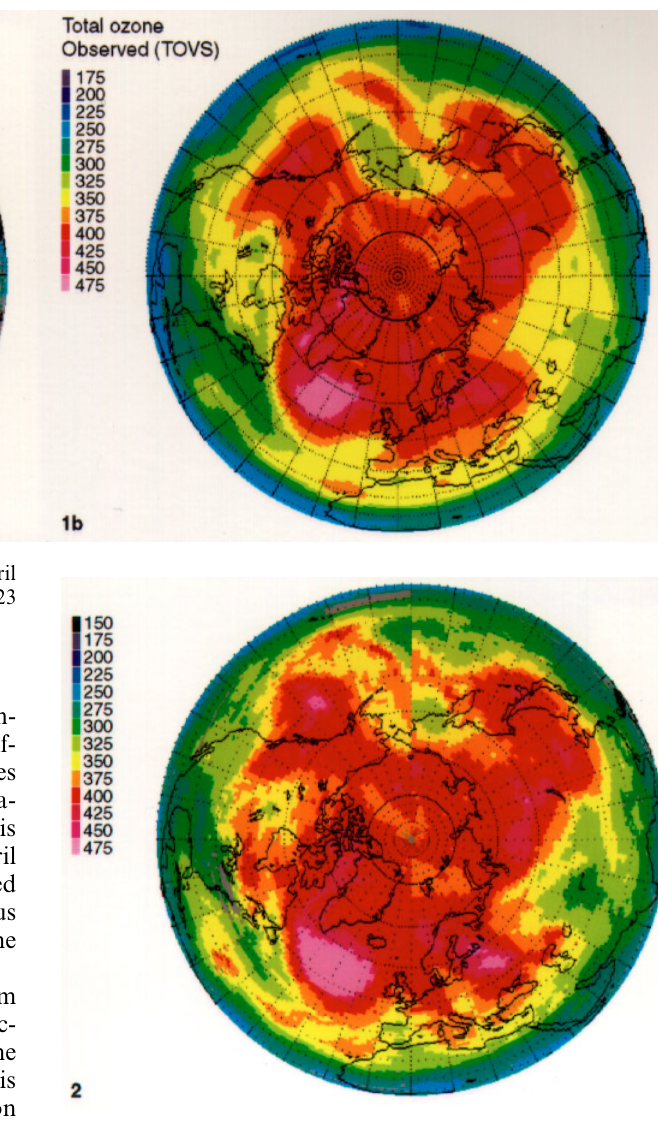
Fig. 2. NASA TOMS total-ozone map (in DU) for 23 April 1992. Spurious gradients are visible at the date line 180 ° E ( top of the picture )